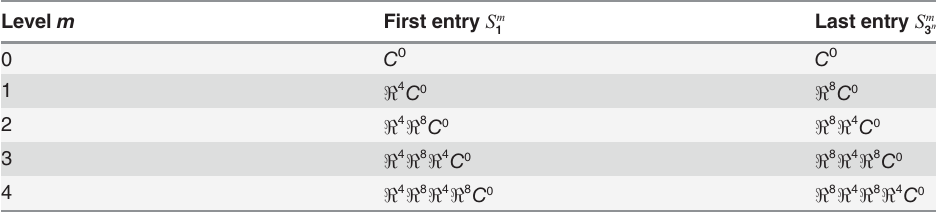
Table 3. First and last entry of the arrowhead sequence at different